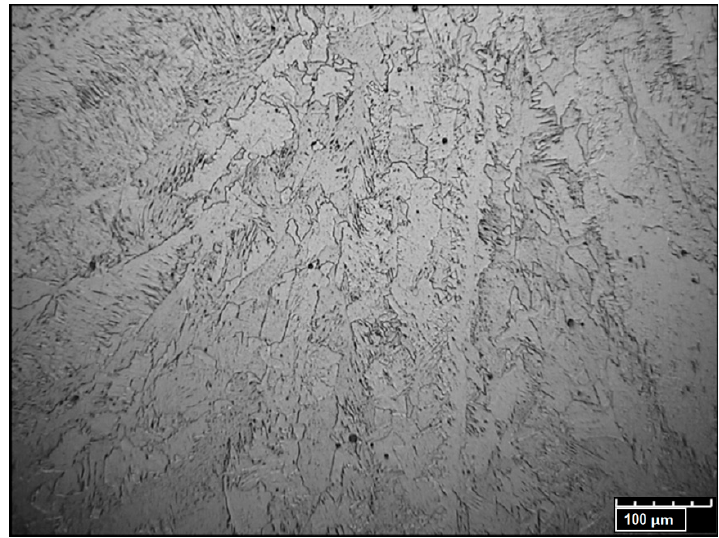
Figure 15. Microstructure of the weld.